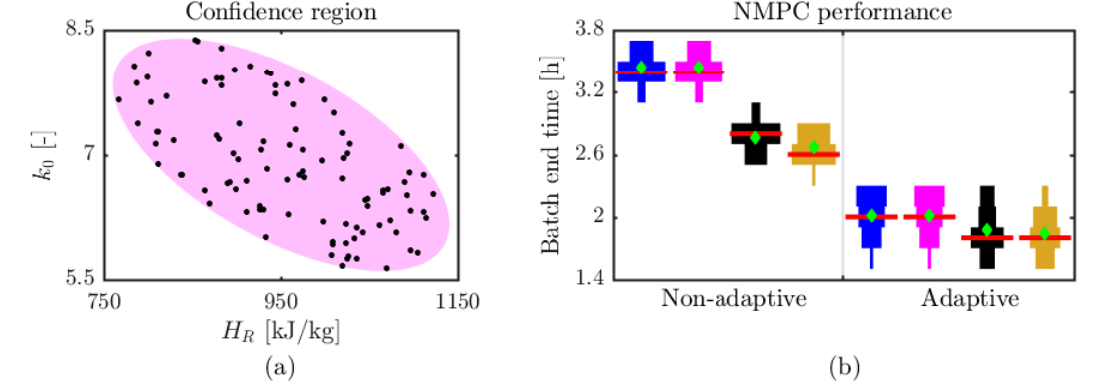
Figure 16. ( a ): True plant parameter values chosen within the initial confidence region of the uncertain parameters to evaluate the performance of non-adaptive and adaptive NMPC schemes ( b ): The violin plot of the batch end time obtained when the plant is controlled using non-adaptive and adaptive NMPC schemes in the presence of measurement noise. represents MS NMPC, A-MS NMPC, represents MS-VA NMPC, A-MS-VA NMPC, represents MS-SB NMPC, A-MS-SB NMPC, and represents MS-CB NMPC, A-MS-CB NMPC. and represent the mean and median values of the number of moles of product C